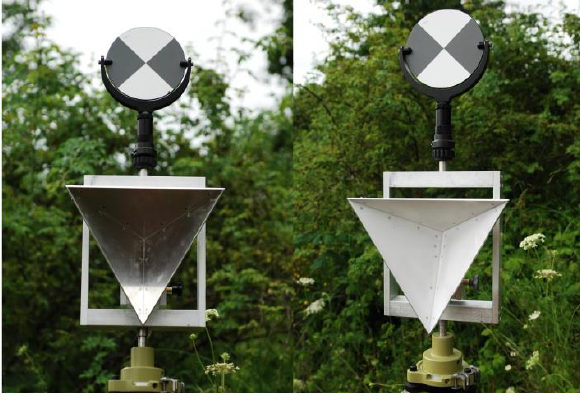
Figure 5: Target without (left) and with dulling spray (right) The applied corner cube reflectors are assembled of three polished aluminium sheets with a longest side of 14 cm which leads to problems during data acquisition by laser scanning.